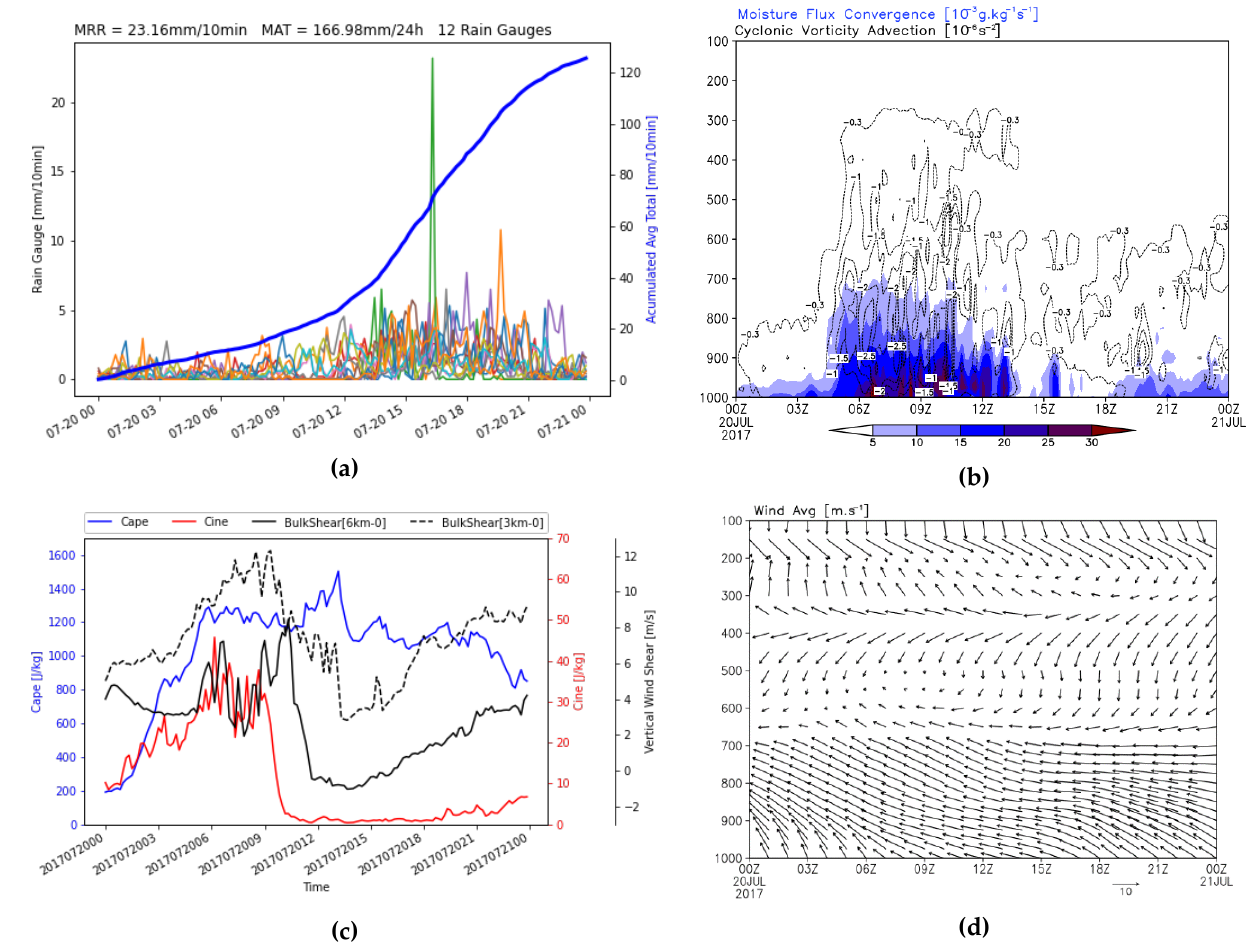
Figure 9. Analysis of the dynamic and thermodynamic variables inside the yellow box for event 2: ( a ) each rain gauge represents a different color (mm/10 min) and 24-h average accumulated precipitation in blue; MRR is for maximum rain rate, and MAT is for maximum accumulated total; ( b ) maximum MFC (10 − 3 g·kg − 1 s − 1 ) and minimum ADV ζ (10 − 6 s − 2 ); ( c ) maximum values of CAPE and CIN (J·kg − 1 ) and maximum values of bukk shear (m·s − 1 ) in their respective layers (outer axis); and ( d ) vertical variation in the mean wind vector (m·s − 1 ).